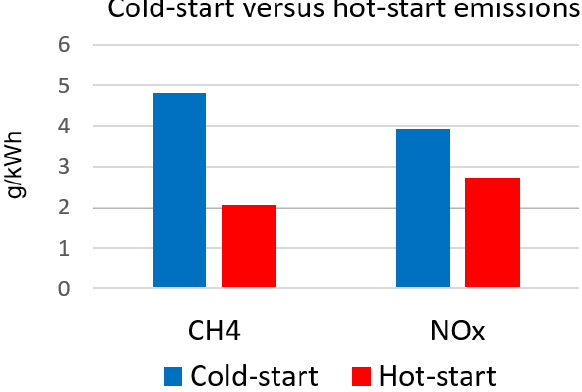
Figure 7. Cold-start versus hot-start emissions.